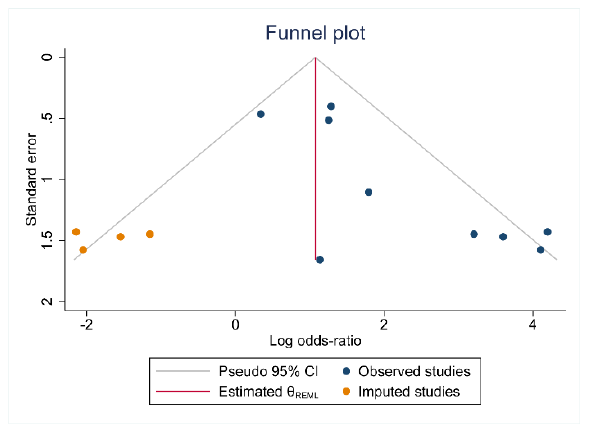
Figure 8. Funnel plot for prognostic value of hs-CRP in in-stent restenosis.